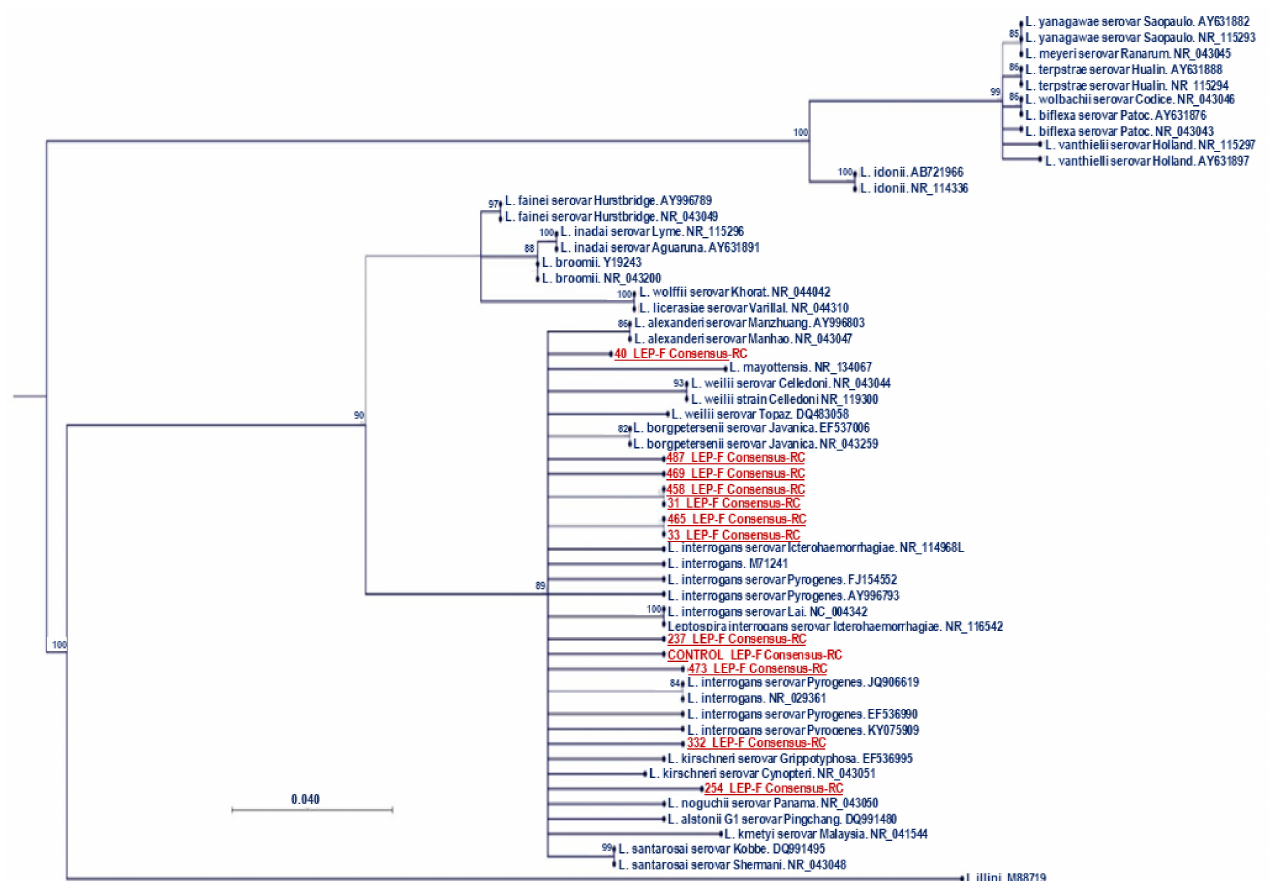
Figure 1. Maximum likelihood phylogenomic tree inferred from partial 16S rRNA sequences from 12 sample sequences (in red) and 45 Leptospira sequences from GenBank (in dark blue). Node support Boostrap values above 80 are indicated at the